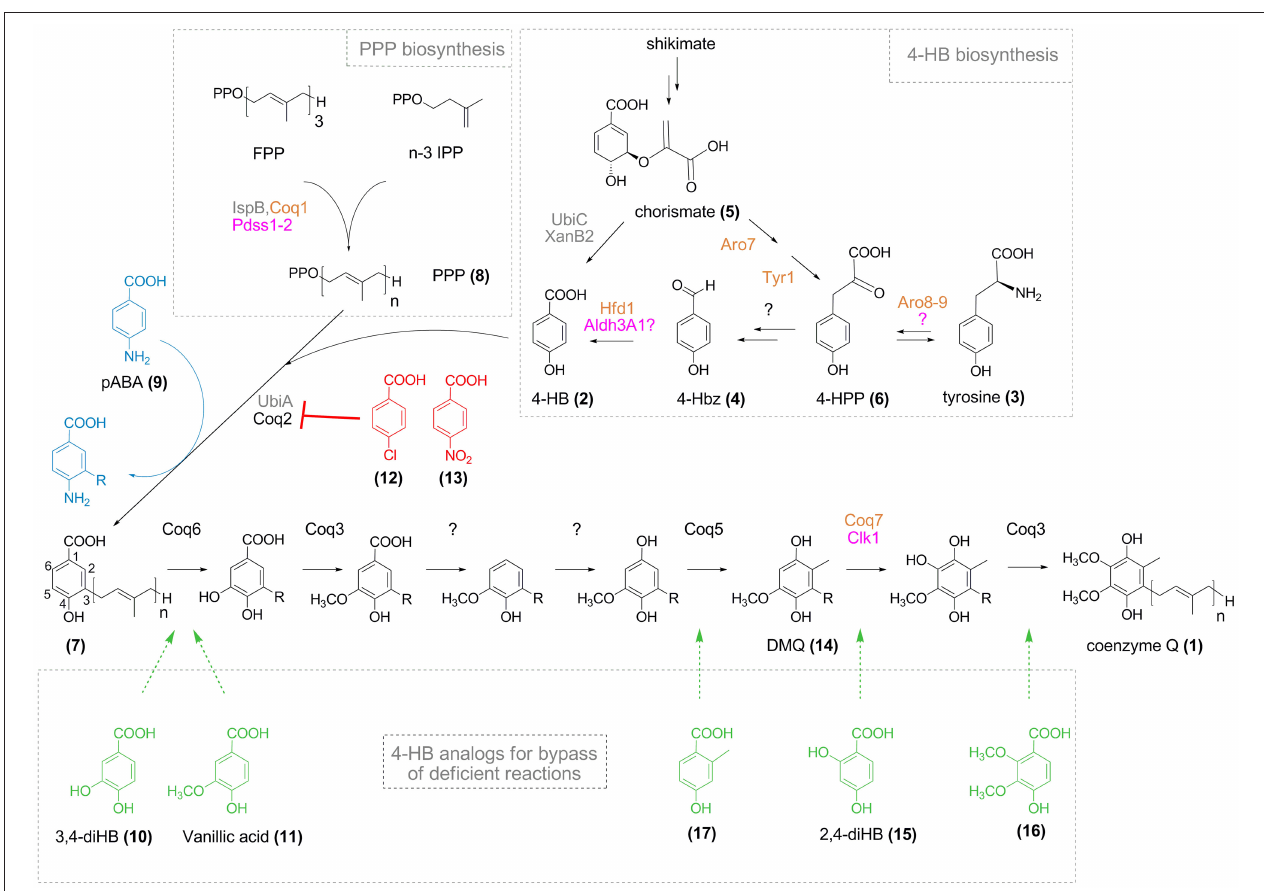
FIGURE 1 | CoQ biosynthesis and effect of 4-HB analogs. Names for enzymes of E. coli , S. cerevisiae, and humans are in gray, orange, and pink, respectively (in black when common to S. cerevisiae and humans). Polyprenyl pyrophosphate (PPP, 8 , n = 6–10) synthesized from farnesyl pyrophosphate (FPP) and n-3 isopentenyl pyrophosphate (IPP) is conjugated to 4-HB ( 2 ) by Coq2/UbiA to yield polyprenyl-4-HB ( 7 ). The numbering of the aromatic carbon atoms is shown on polyprenyl-4-HB and is uniformly applied to the different intermediates cited in the text, although IUPAC nomenclature might be different depending on the substitution pattern. Since the order of some reactions is different in bacteria (Aussel et al., 2014), only the eukaryotic pathway from polyprenyl-4-HB to CoQ is shown. R corresponds to the polyprenyl moiety ( n = 6–10). 4-Chlorobenzoic acid ( 12 ) and 4-nitrobenzoic acid ( 13 ) (red) are inhibitors of Coq2/UbiA, whereas pABA ( 9 , blue) is prenylated and progress to different stages of the CoQ biosynthetic pathway depending on the organisms (see text for details). 4-HB analogs (in green) have potential ( 16, 17) or proven ( 10, 11, 15 ) capacities to bypass the biosynthetic steps indicated by the dashed arrows.